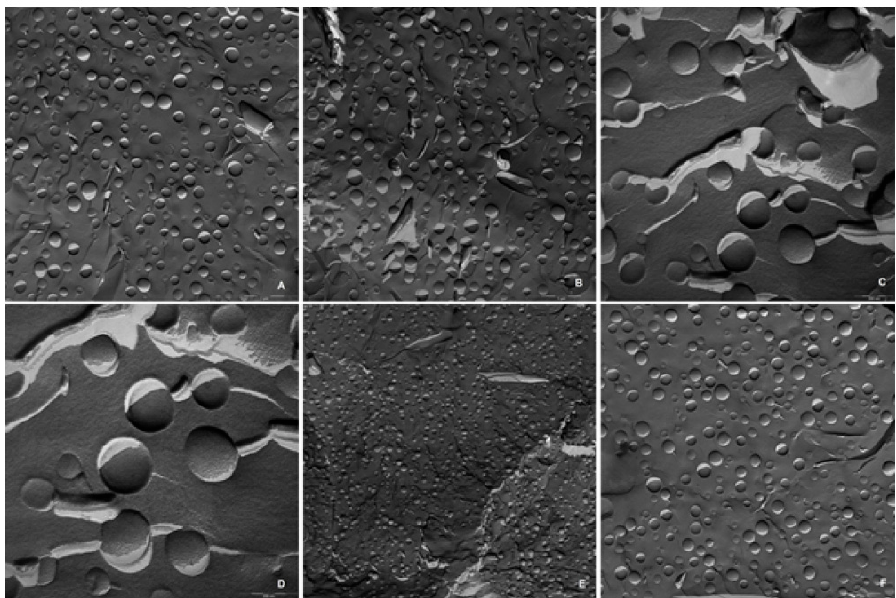
× ( A , B , F ), 50,000 × ( C , D ), 8000 × ( E